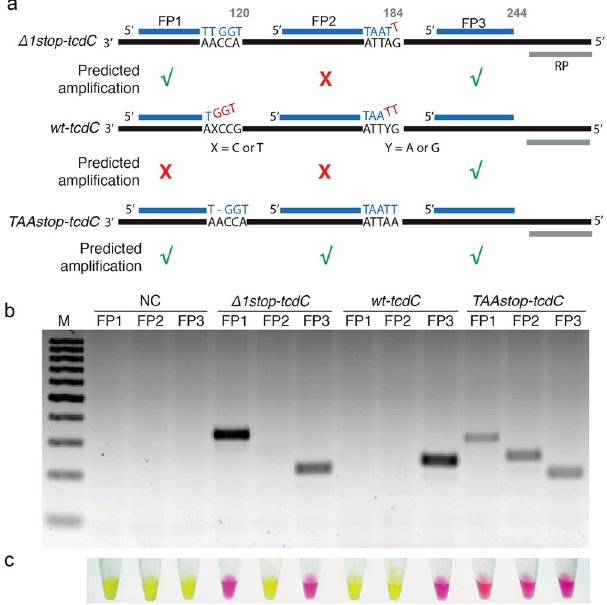
Figure 2. PCR-based tests for the wildtype and two mutated tcdC genes. ( a ) Primer design. Primers for tcdC genes are color-coded. The mismatched 3 ′ terminus between forward primer and template are shown in red. Green tick and red cross denote a successful and unsuccessful PCR reaction, respectively. ( b ) Analysis of PCR products by 2% agarose gel electrophoresis. ( c ) Litmus test with PCR products. The photographs were taken at 30